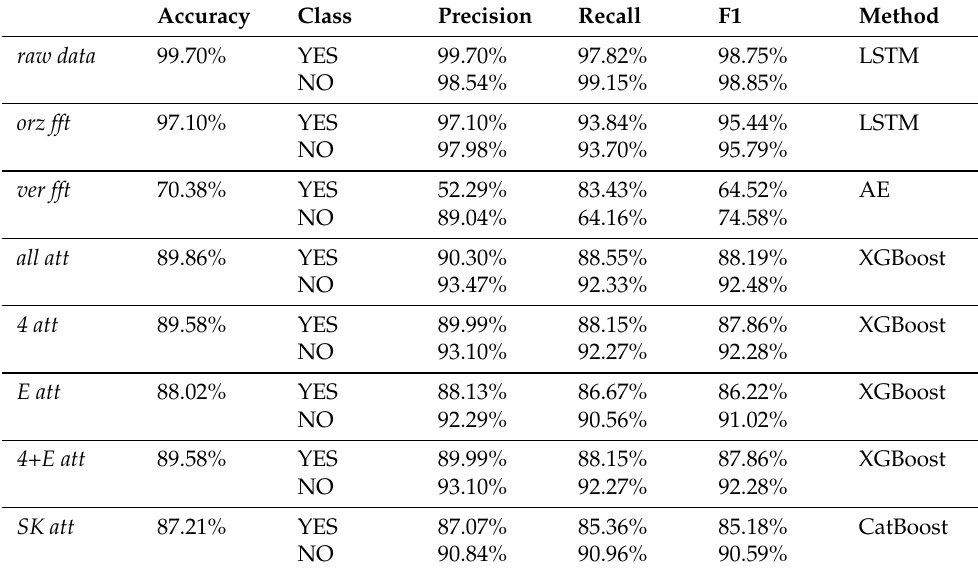
Table 4. Supervised methods—static case.